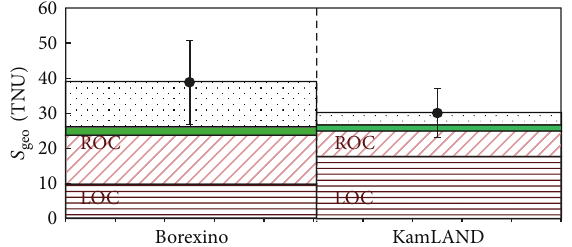
Figure 9: The measured geo- ] signal in Borexino and KamLAND compared to the expected fluxes from Table 1: area with horizontal stripes = LOC, area with oblique stripes = ROC, green solid area = CLM. The dotted area is the excess of signal which could correspond to the convective mantle contributions. The sum of the CLM and the convective mantle contributions corresponds to the total mantle signal as from